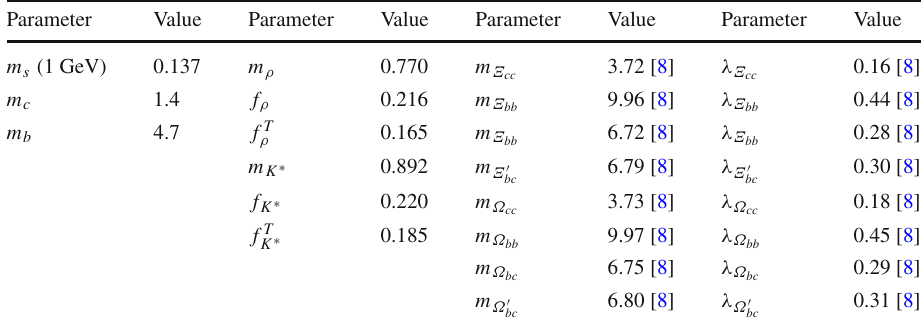
Table 1 The values of the input parameters entering the sum rules. All the masses and decay constants are in units of